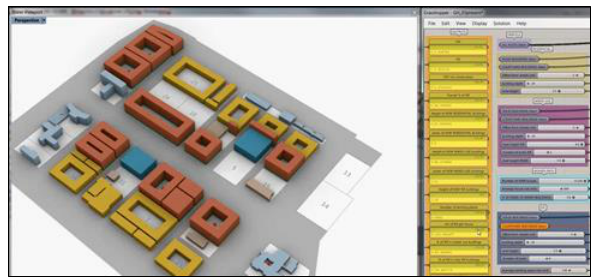
Figure 9. Example of the Graphical Interface of the tool. [Left] 3D visualization in the Rhinoceros viewport. [Right] Grasshopper window with info panels and data